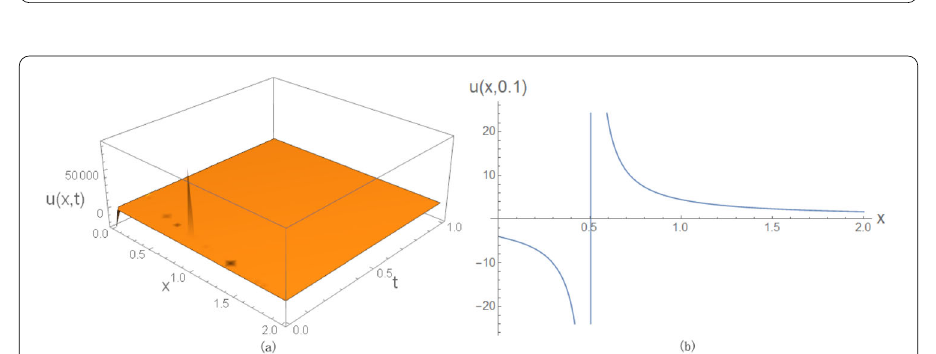
Case 2. For α = 0.7 (Fig.